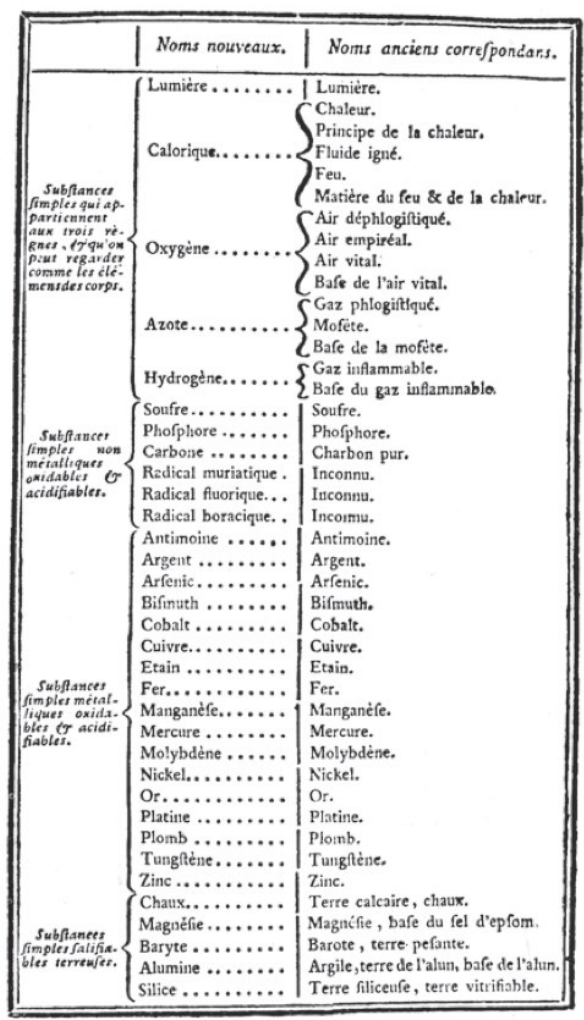
Figure 2. Lavoisier’s classification of the elements.